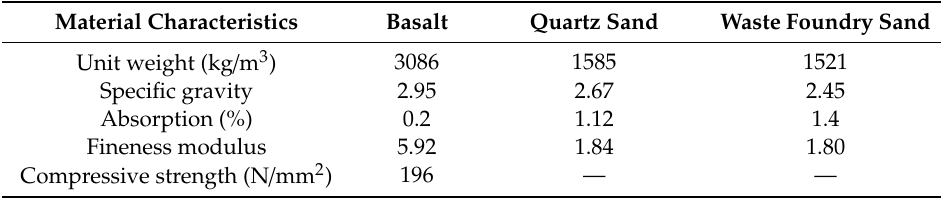
Table 3. Physical properties of basalt aggregate, quartz sand, and waste foundry sand (WFS).